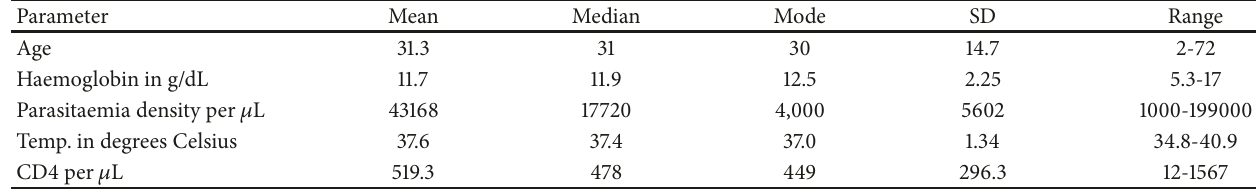
Table 1: Profile of parasite density, temperature, Hb, and CD4 cells count of participants.